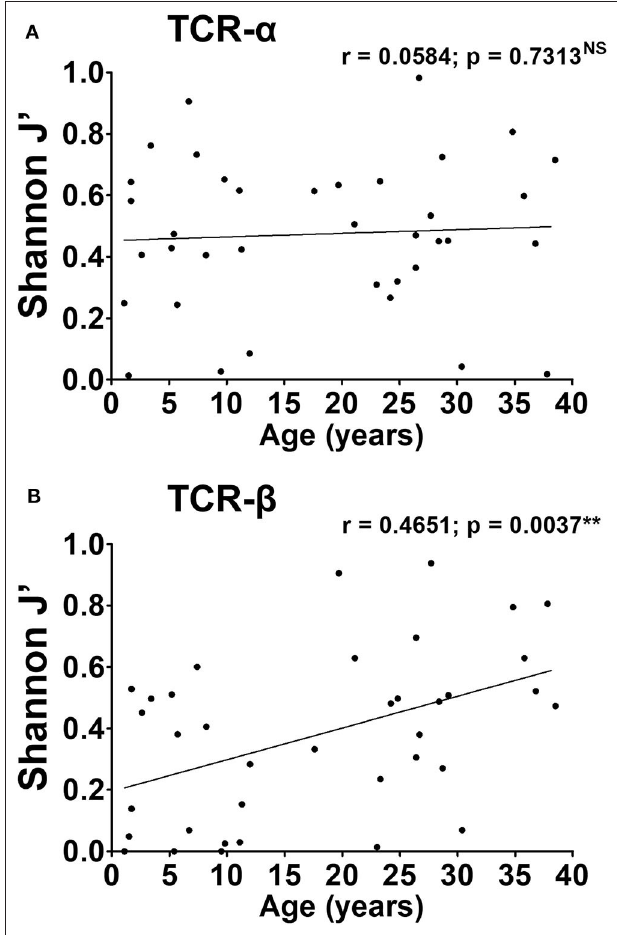
FIGURE 3 | CMV-associated TCR repertoire perturbation arises in early life and is maintained over time. Oligoclonality of the TCR- α (A) and - β chain (B) repertoire was calculated as outlined in Materials and methods for each time point. J ′ values of 0 have been used to represent monoclonal samples. Spearman’s r was computed for every parameter and shown above the corresponding graph. P -values < 0.05 were considered significant (** p < 0.01, NS, not